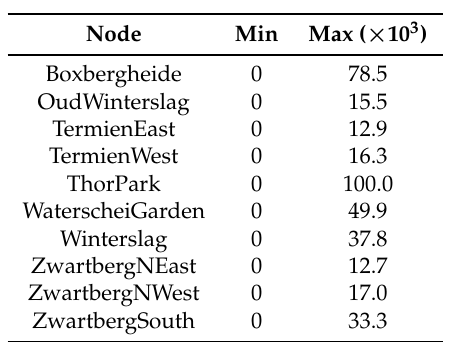
Table 2. Available design choices for the installed STC array area per node. All nodes except ThorPark consider the total available South-oriented rooftop area of the considered buildings in that neighbourhood. All numbers are expressed in m 2 .